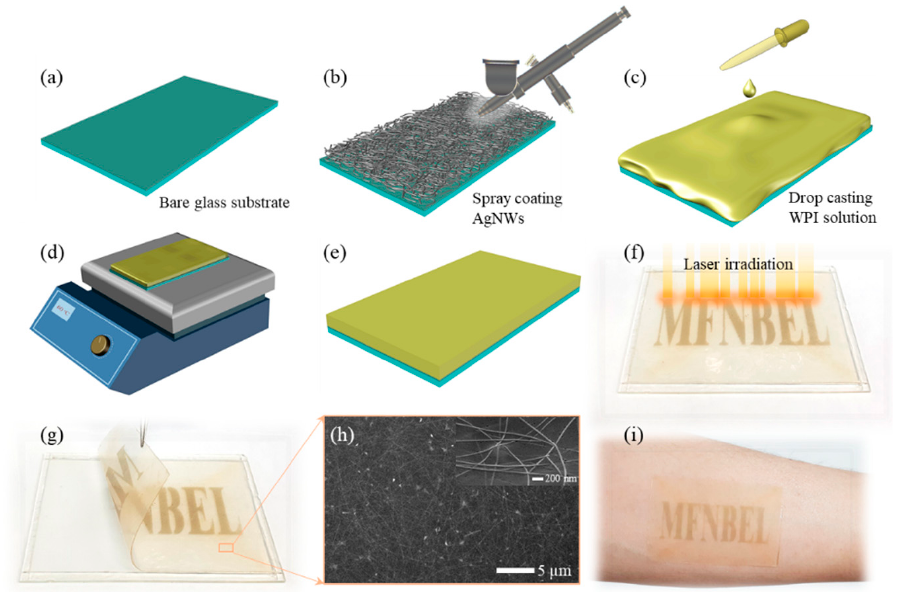
Figure 2. ( a – e ) Fabrication of freestanding transparent AgNWs/WPI film. ( f , g ) Laser irradiation on AgNWs for appearance followed by peel-off. ( h ) SEM micrograph of the spray-coated AgNWs. ( i ) AgNWs/WPI film transferred onto the human skin.